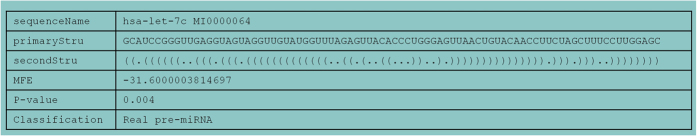
An example of prediction result.If the classification is predicted to Real pre-miRNA, it indicates the query most probably is a pre-miRNA. Some useful information is also provided, including second structure, MFE and P-value.